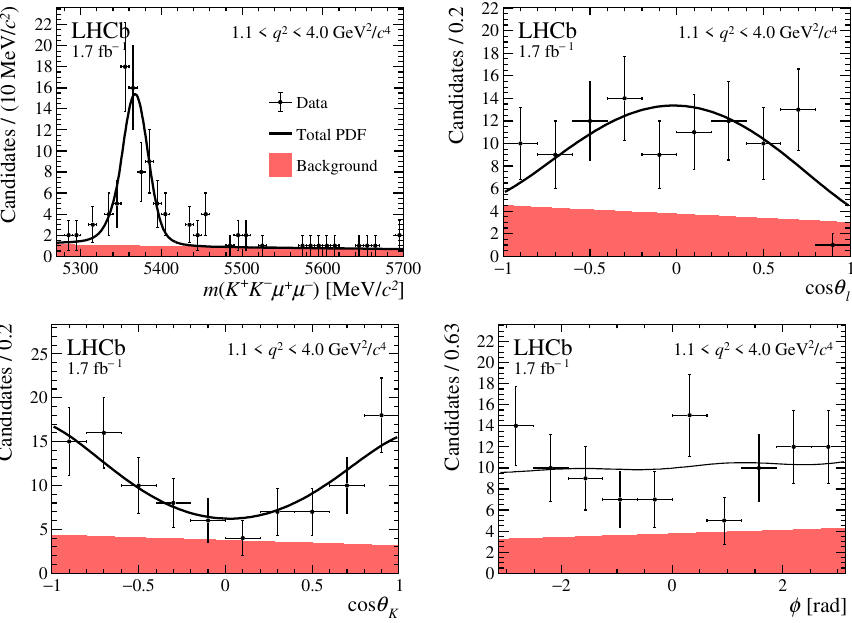
Figure 16 . Mass and angular distributions of B 0 1 . 1 < q 2 < 4 . 0 GeV 2 /c 4 for data taken in 2016. The data are overlaid with the projections of the fitted PDF.